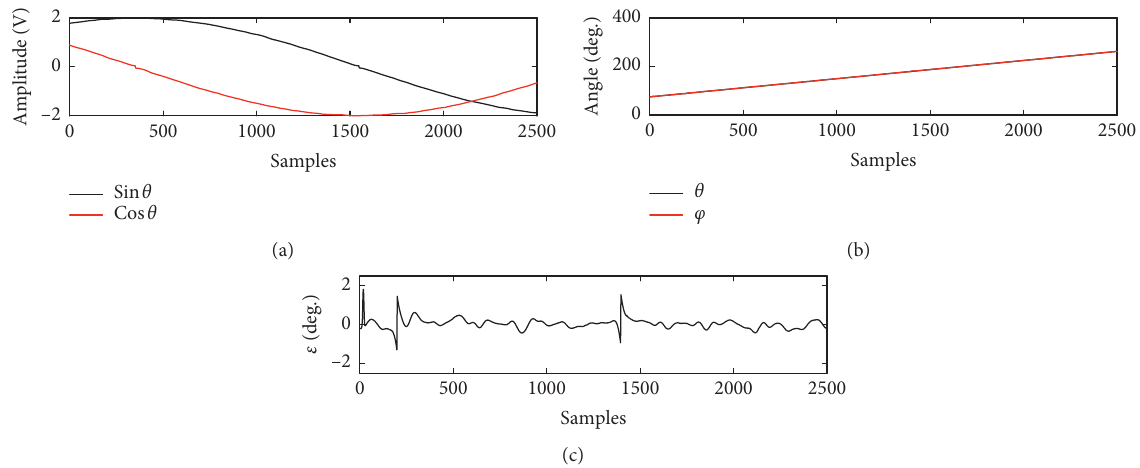
Figure 6: Simulation results using the filter. (a) Demodulation signals. (b) Rotor angle. (c) Angle error.